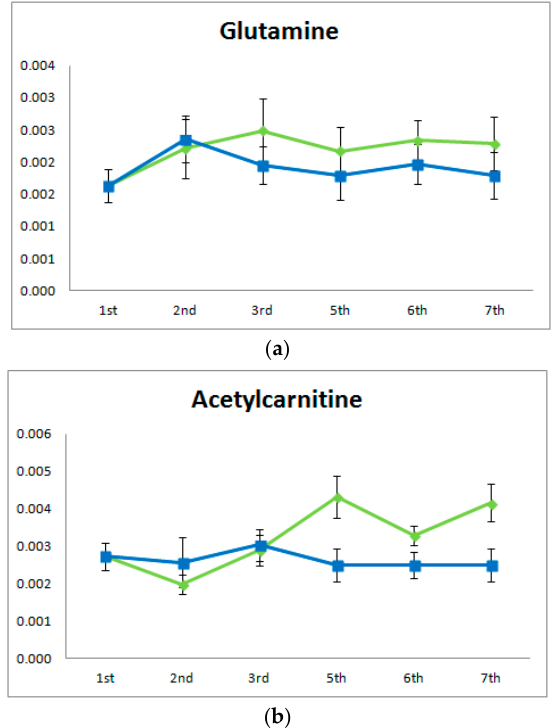
Figure 3. Average of peak areas of rat urine samples of exercise group B (green colored) and sedentary group A (blue colored) at six sampling time points. ( a ) Glutamine; ( b ) Acetylcarnitine.